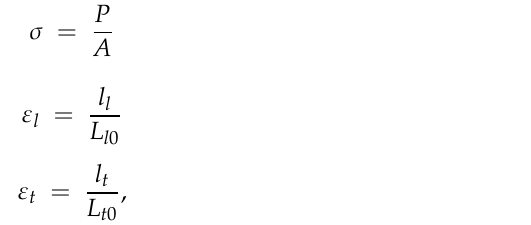
Figure 4. Axial tensile test: ( a ) Schematic representation and ( b ) Photo of test.